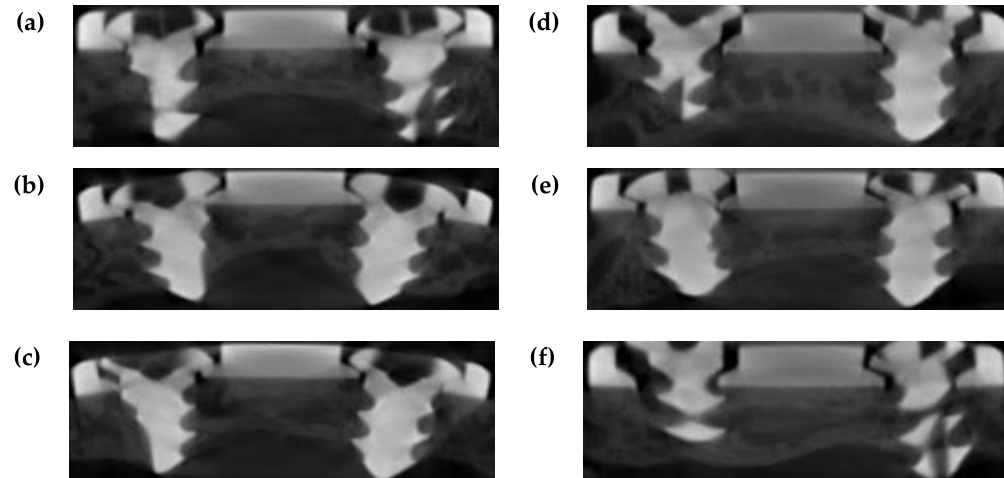
Figure 14. ( a – c ) Micro-computed tomography (micro-CT0 images of the untreated two-hole straight plates after four weeks. One can see that weak bone formed on the bone-side surface of the metal plate. ( d – f ) Micro-CT images of the two-hole straight plates treated with amine plasma after four weeks. One can see that dense bone formed on the bone-side surface of the titanium plate.